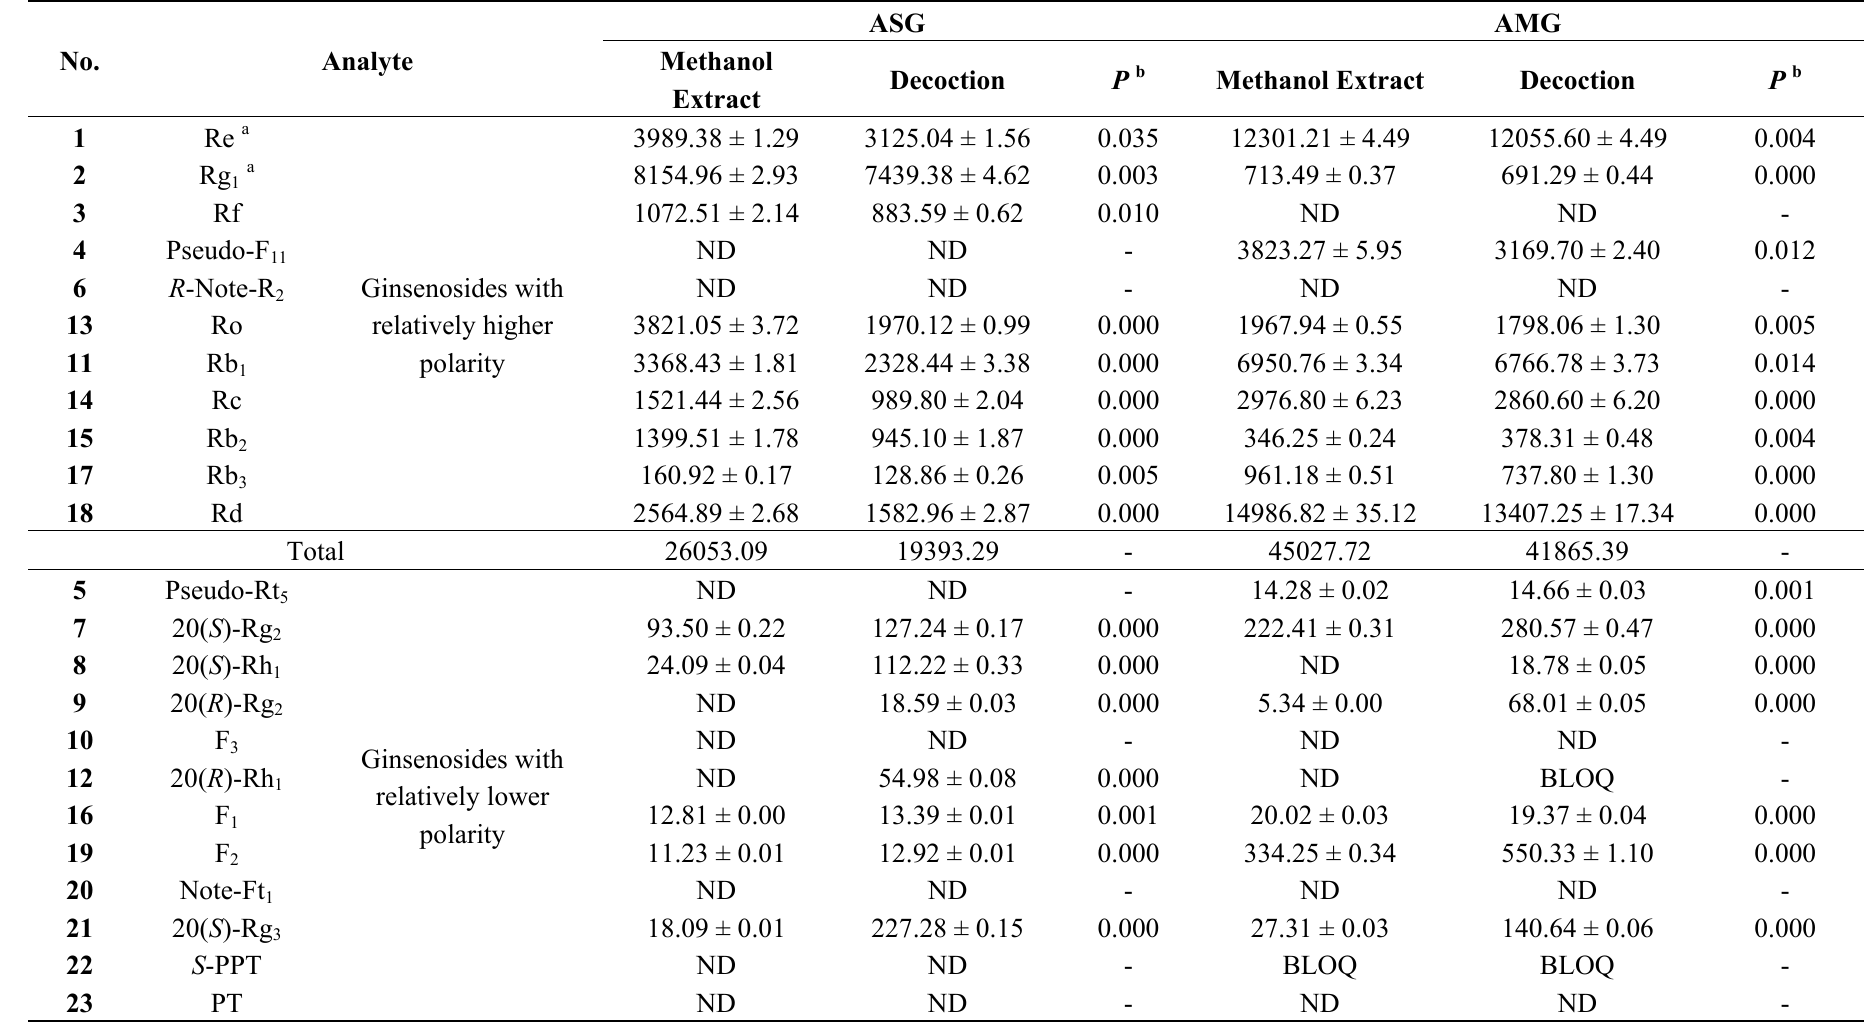
Table 3. Contents of 30 analytes in methanol extracts and decoctions of ASG and AMG samples ( μ g/g, n =